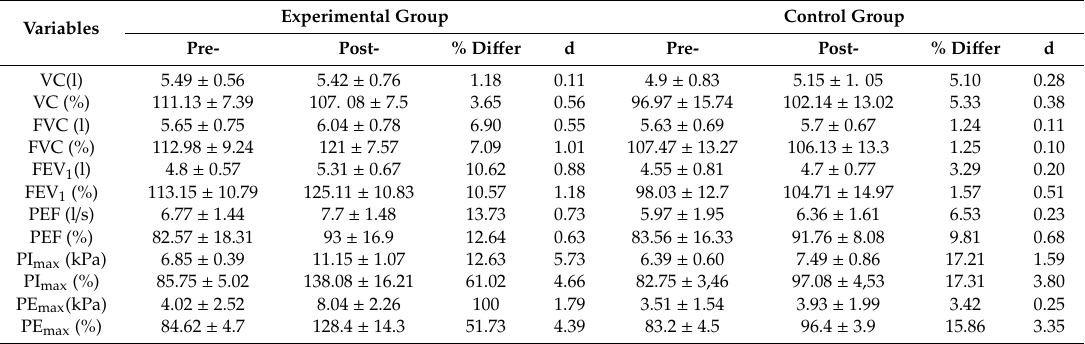
Table 3. Statistical characteristics of selected pulmonary function data pre- and post-application of inspiratory muscle training (IMT).